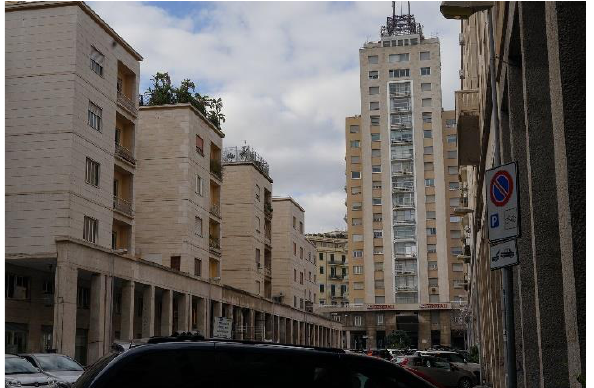
Figure 5: The inner courtyard of the urban complex.